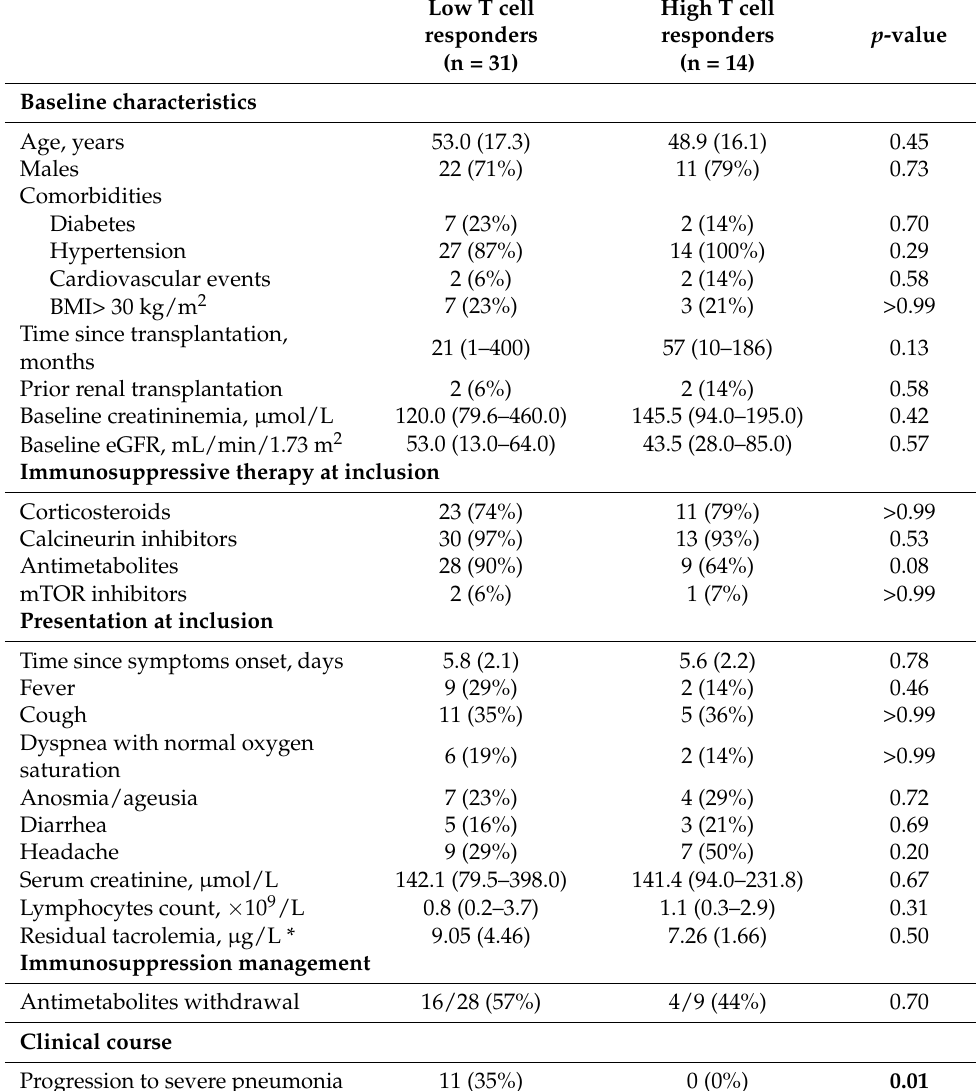
Table 2. Sample characteristics of low and high T cell